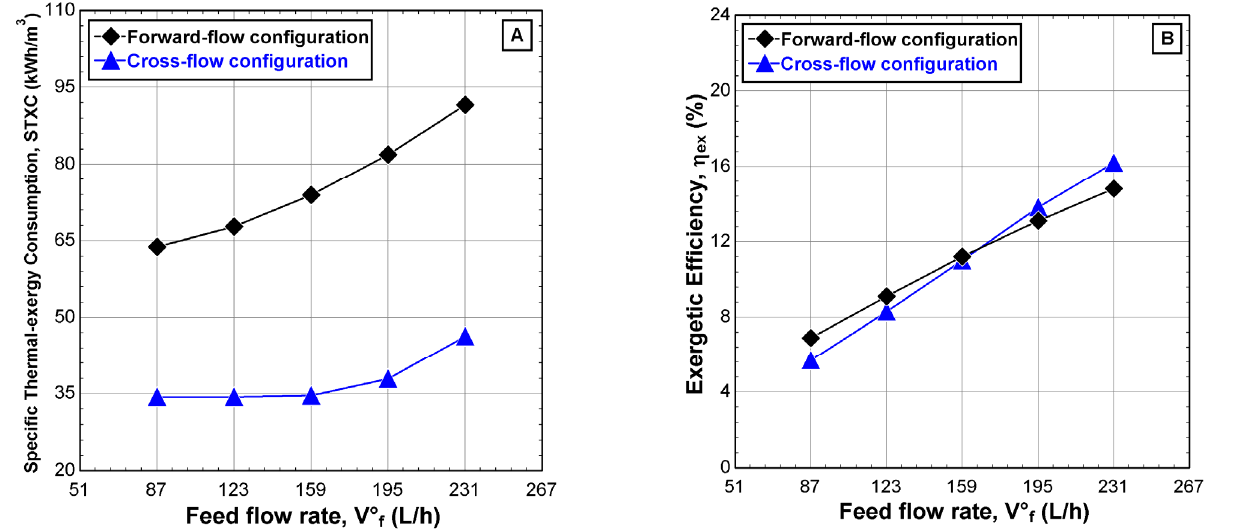
. v F 3 on ( A ) specific thermal exergy consumption and ( B ) ex- Figure 12. Effect of the feed water flow, Membranes 2022 , 12 , x FOR PEER REVIEW . . Figure 12. Effect of the feed water flow, 𝑣(cid:4662) (cid:3007)(cid:2871) on ( A ) specific thermal exergy consumption and ( B ) v H 1 = 900 L/h, T H 1 = 75 ◦ C, v C 1 = 405 L/h, ergetic efficiency for different feed-flow configurations ( exergetic efficiency for different feed-flow configurations ( 𝑣(cid:4662) (cid:3009)(cid:2869) = 900 l/h, T (cid:3009)(cid:2869) = 75 °C, 𝑣(cid:4662) (cid:3004)(cid:2869) = 405 l/h, T C 1 = 20 ◦ C, C F 3 = 1260 ppm, and P v = 11.5 kPa). T (cid:3004)(cid:2869) = 20 °C, 𝐶 (cid:3007)(cid:2871) = 1260 ppm, and 𝑃 (cid:3049) = 11.5 kPa).